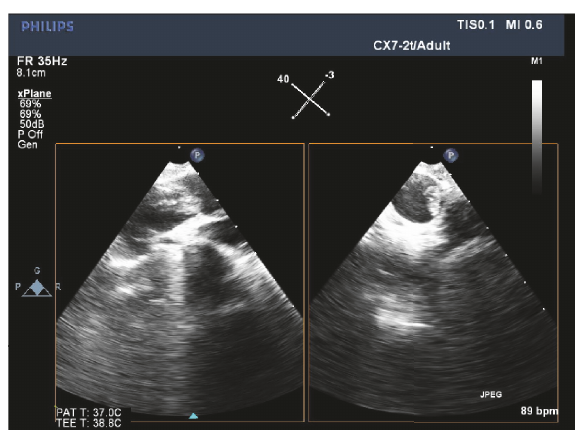
Figure 2: TEE mid-esophageal view of PA with x-plane mode showing large embolus with subtotal occlusion in right PA.